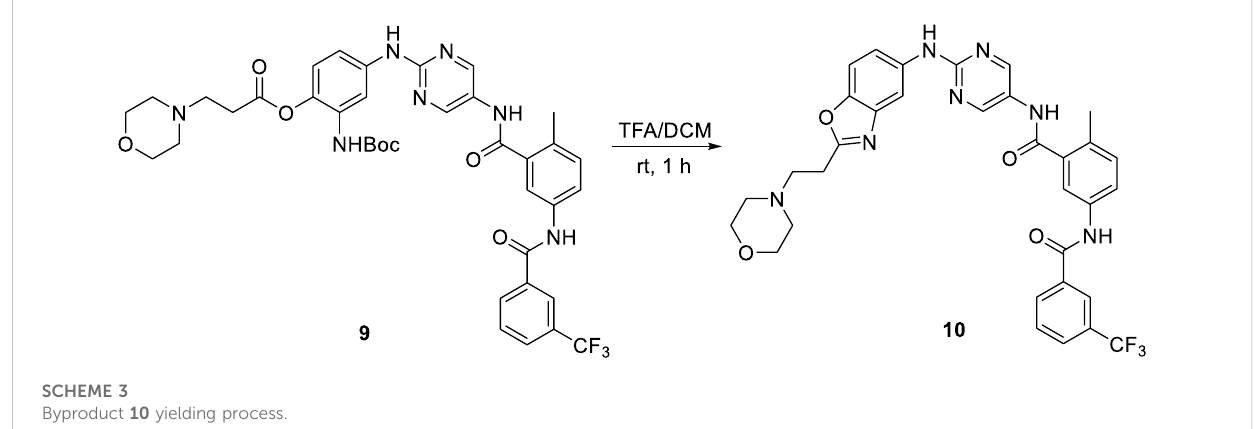
SCHEME 3 Byproduct 10 yielding